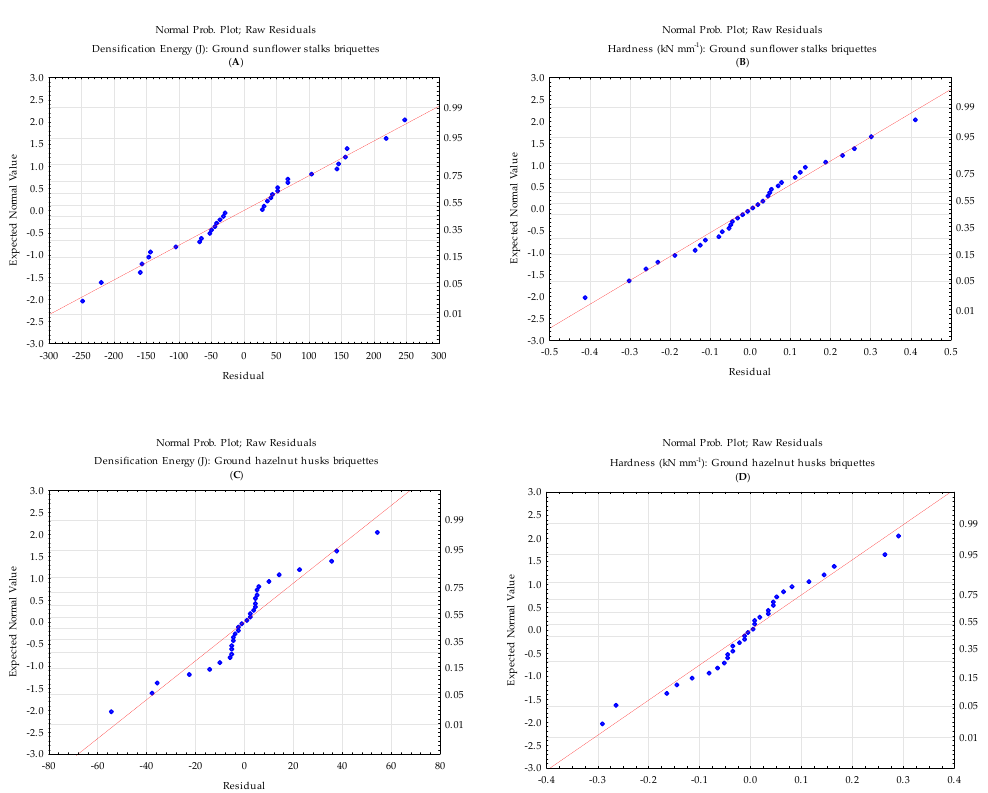
Figure 8. Normal probability plots of densification energy ( A ) and hardness ( B ) of ground sunflower stalk, and densification energy ( C ) and hardness ( D ) of ground hazelnut husk briquettes under the effects of forces and particle sizes similar to other determined parameters.